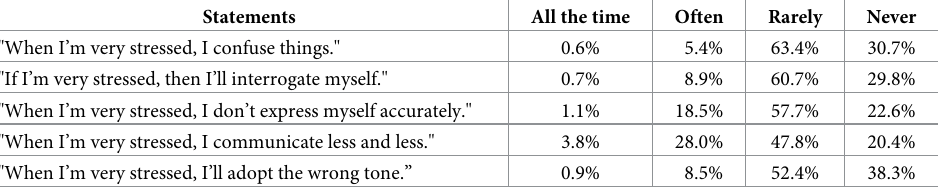
Table 4. Communication in stressful situations.